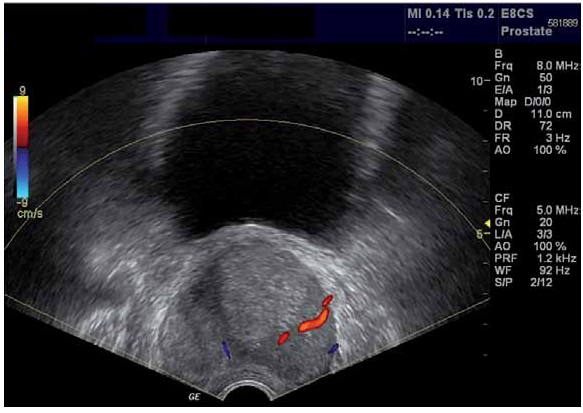
Figure 1 - PDUS examination of the prostatic vasculature showing capsular arteries.